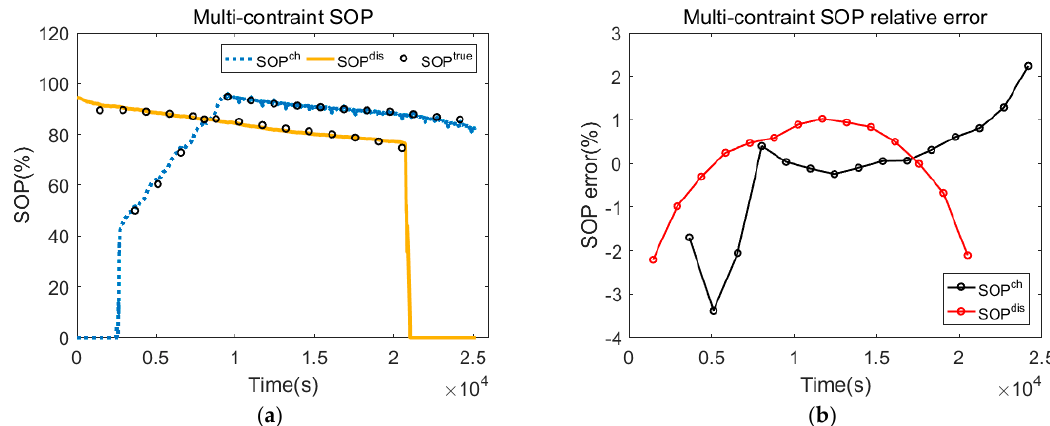
Figure 11. ( a ) SOP under multiple constraints; ( b ) Relative errors.